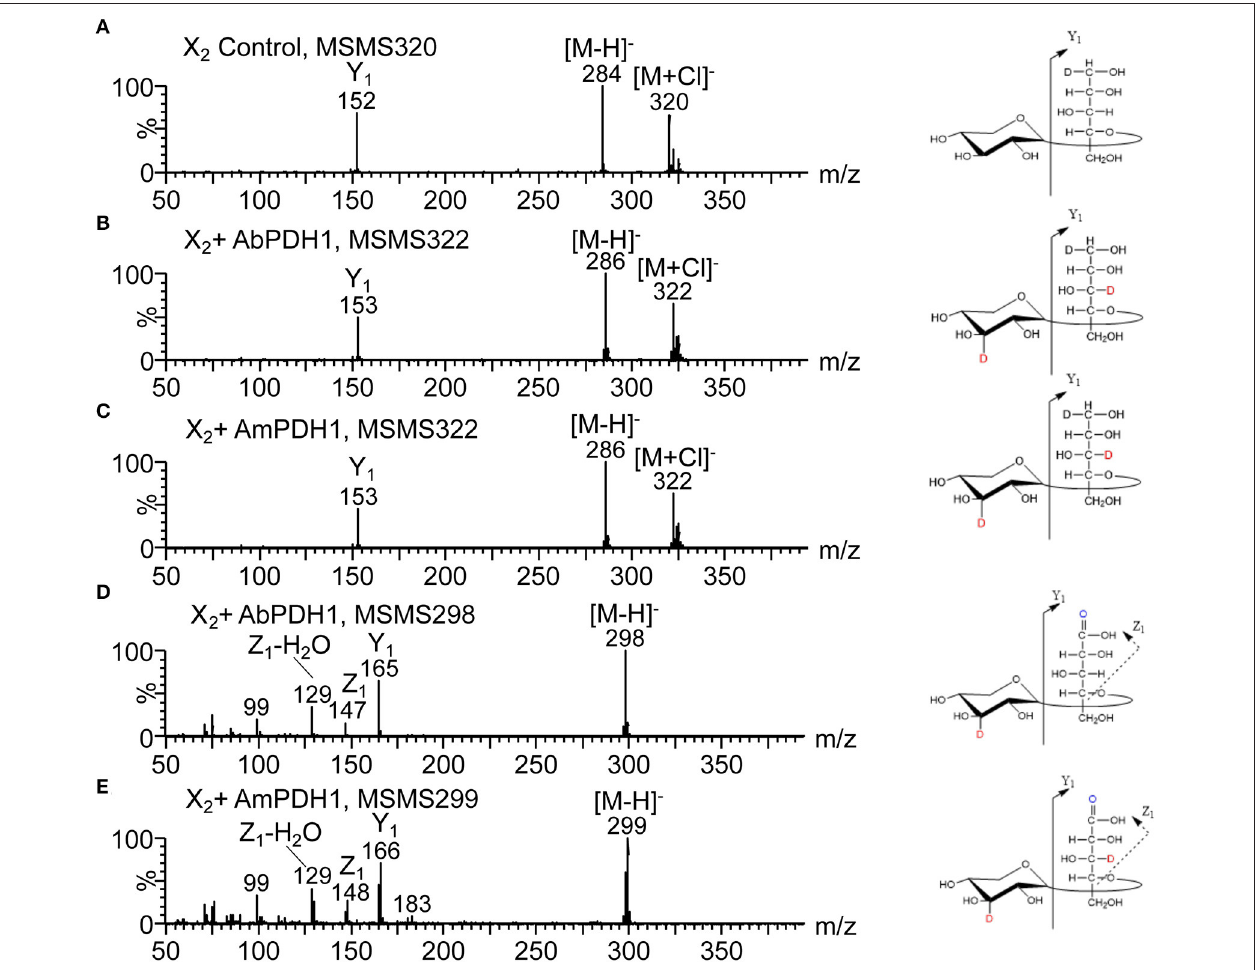
FIGURE 6 | HILIC-MS/MS spectra collected in negative ion mode showing fragmentation of X 2 after enzymatic oxidation by PDHs followed by NaBD 4 reduction. (A) Negative MS/MS 320 of the X 2 control, (B) negative MS/MS 322 of the X 2 oxidized by AbPDH1, (C) negative MS/MS 322 of the X 2 oxidized by AmPDH1, (D) negative MS/MS 298 of the X 2 oxidized by AbPDH1, (E) negative MS/MS 299 of the X 2 oxidized by AmPDH1. Product ions named according to Domon and Costello (1988) . Oxidations at C-2, C-3, and C-4 are not